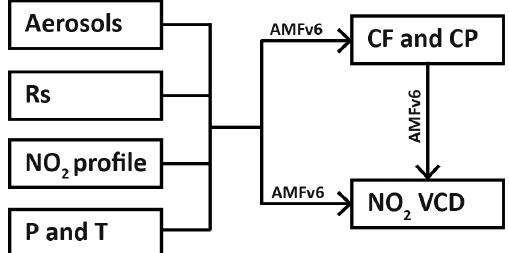
Figure 2. A diagram to illustrate our reference retrieval (case REF, representing our POMINO product). Here Rs is surface reflectance, P is air pressure, and T is air temperature. See Sect. 2.2 and Table 1 for detailed descriptions of our retrieval approach and